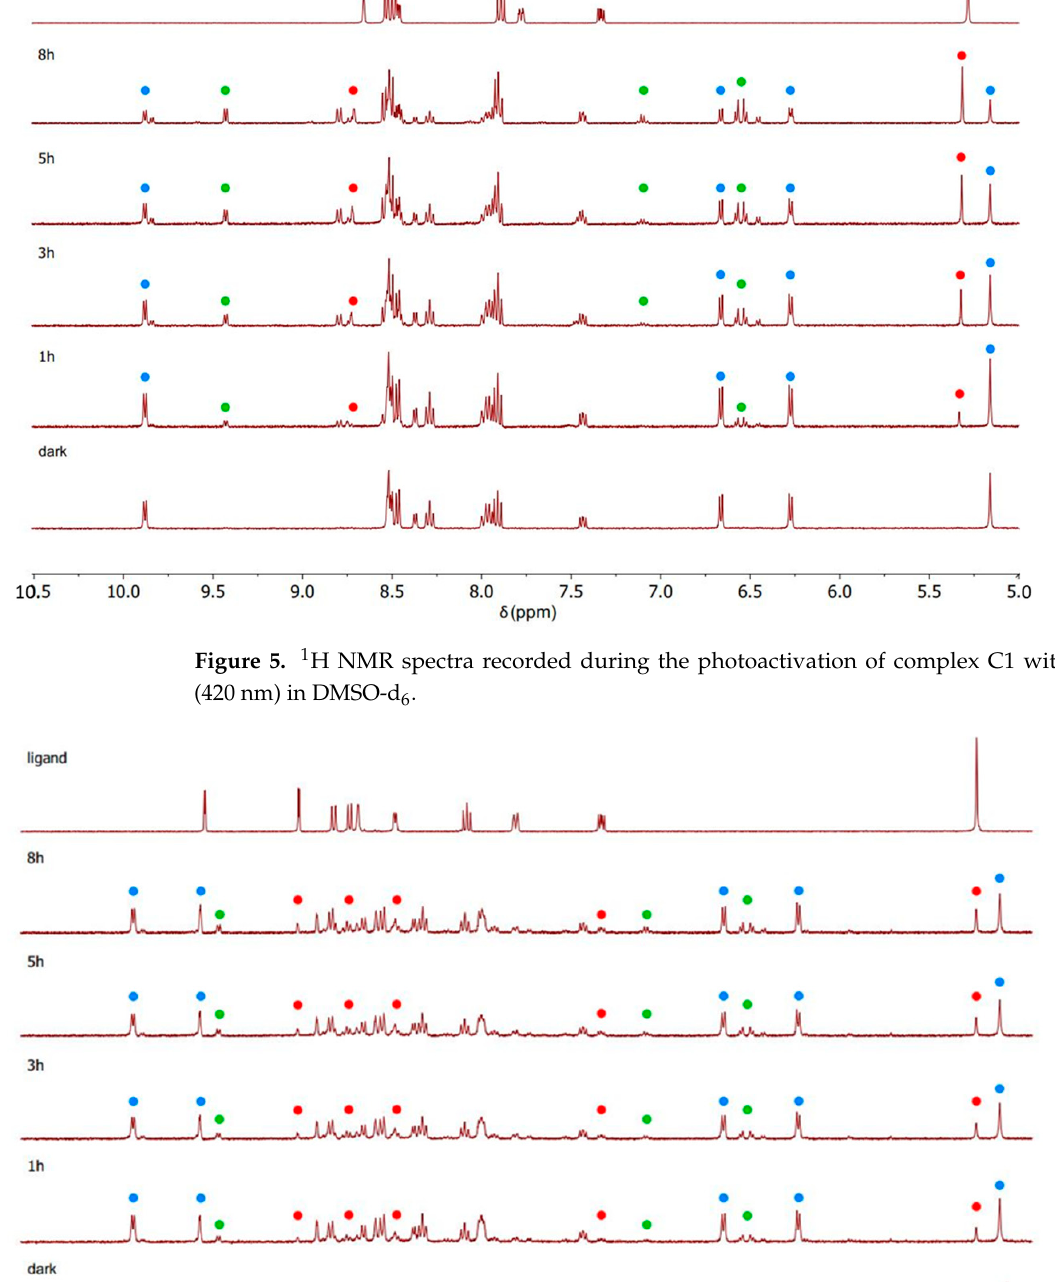
Figure 6. 1 H NMR spectra recorded during the photoactivation of complex C2 with blue light (420 nm) in DMSO-d 6 .